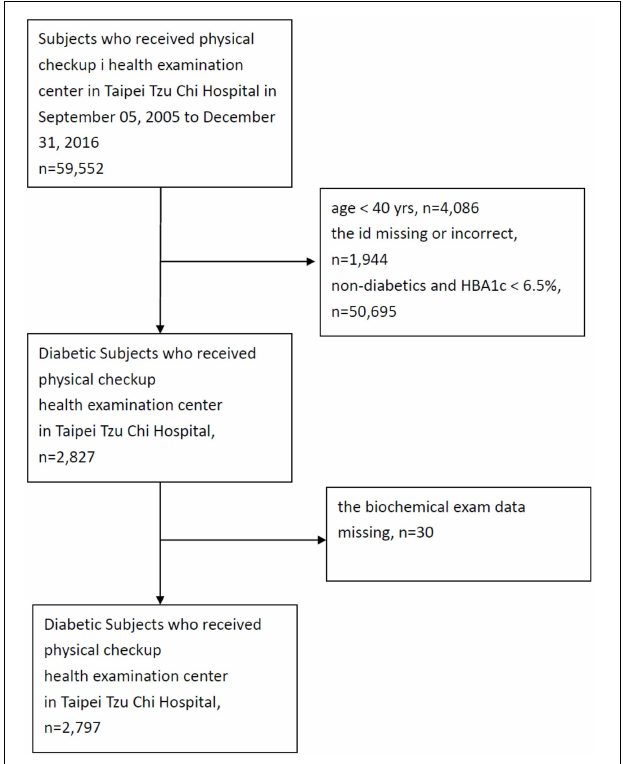
FIGURE 1 | The flow chart for subject selection process in this